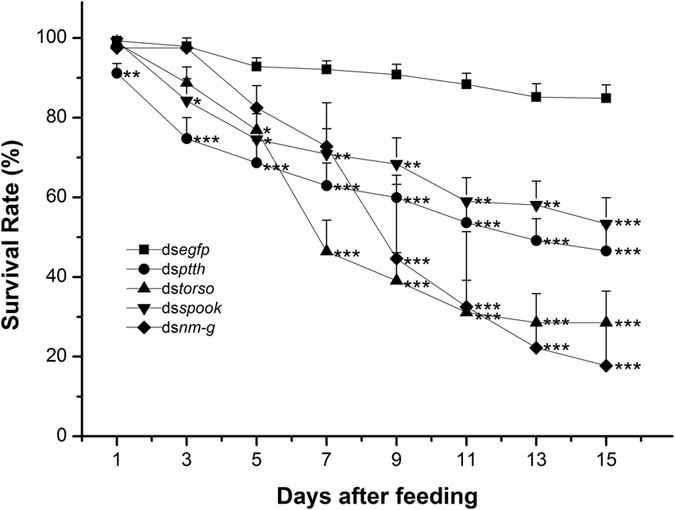
The change of larval survival of Chilo suppressalis after dietary ingestion dsegfp, dsptth, dstorso, dsspook, dsnm-g.The insects were continuously exposed to dsRNA through 3-day-old larvae. Larvae fed with dsegfp were used as negative control. Asterisk shows significant difference (*p < 0.05, **p < 0.01 and ***p < 0.001, Student’s t-test).